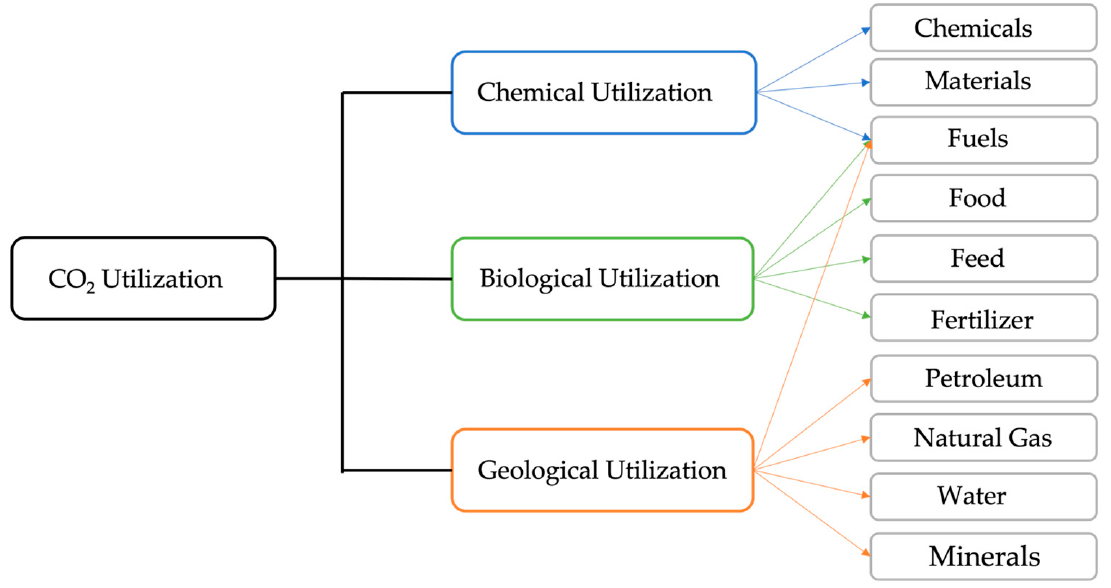
Figure 4. CO 2 utilization classification [97].